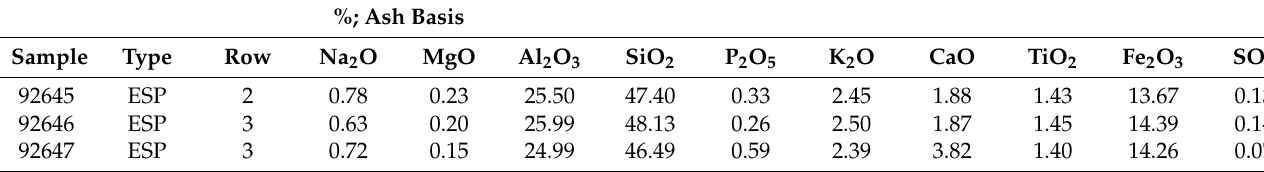
Table 2. Major oxides. dl—detection